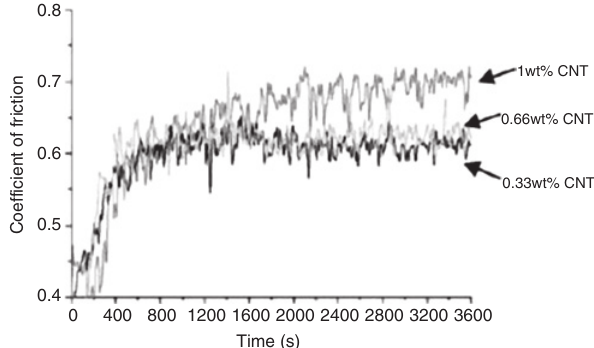
Figure 5 Friction coefficient according to %CNT content.